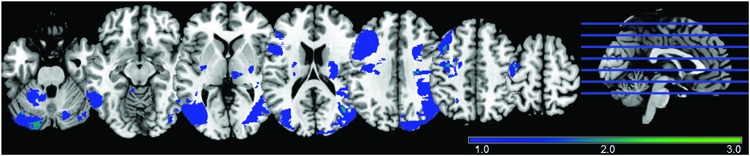
Lesion Density Map for 30 ischemic stroke patients (early and late combined), with most lesions not overlapping.